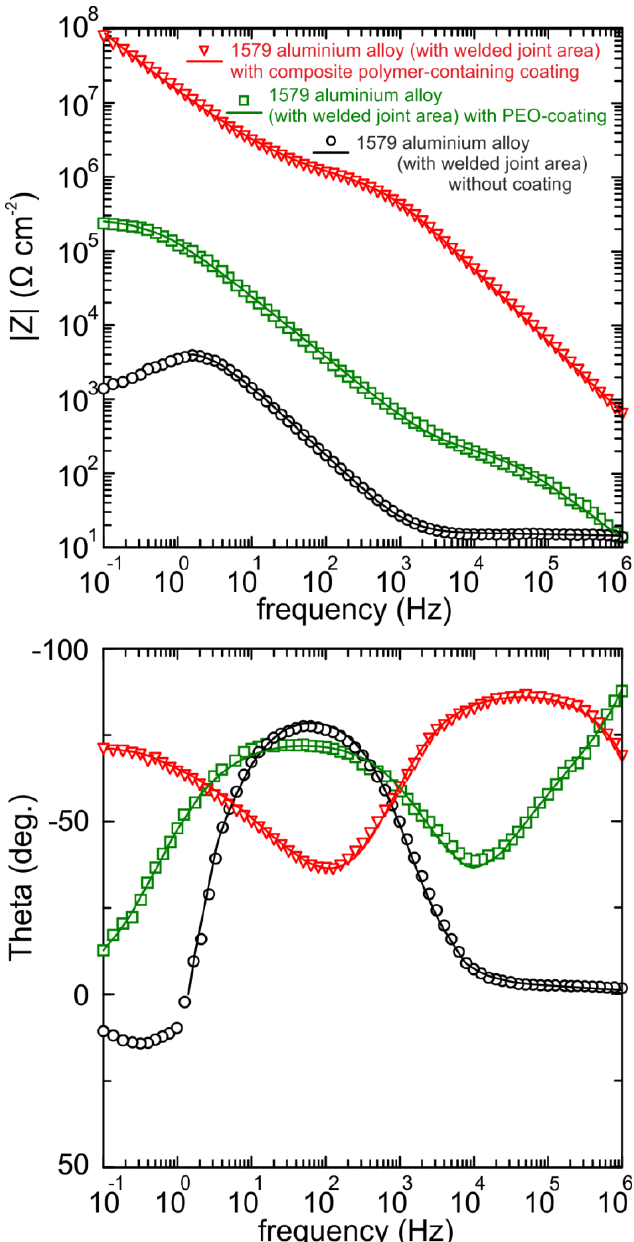
Figure 14. Impedance spectra for the samples made of 1579 aluminium alloy (with the welded joint area) without coating (circle symbols), with PEO-coating (square symbols), and with composite polymer-containing coating (triangle symbols) obtained in 0.5 NaCl solution. The graphs of the dependence of the impedance modulus (| Z |) and phase angle ( Theta ) on frequency (Bode plots). The phase angle ( Theta ) dependences on the frequency (Figure 14) reveal the morphological properties ’ changes as well as specimen heterogeneity after the PEO-layer and polymer-containing coating formation. The EIS spectrum of the sample without coating has one time constant due to the presence of the natural oxide film on the surface, i.e., it can be described by EEC with one R 2 – CPE 2 -circuit ( CPE — Constant Phase Element), where R 2 is the charge transfer resistance and CPE 2 is the double layer capacitance at the electrode/electrolyte interface (Figure 15a) [34]. The positive phase angle values at low frequencies are related to intermediate products ’ adsorption as a result of the pitting corrosion process [48]. Due to surface layer corrosion destruction, the electrochemical